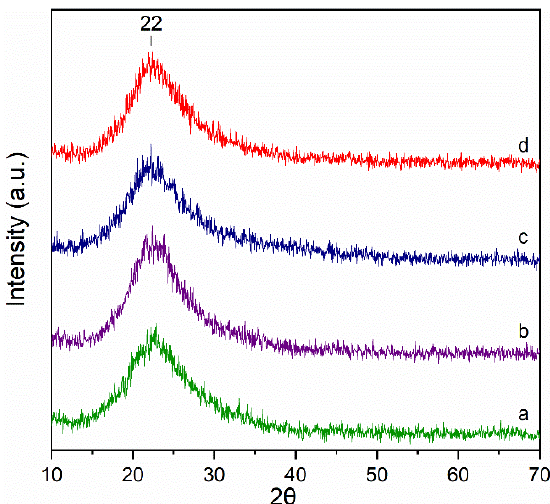
Figure 3. X-ray diffraction (XRD) patterns of samples: (a) SiO 2 , (b) NH 2 -SiO 2 , (c) Pd-P/NH 2 -SiO 2 , (d) Pd 0 /NH 2 -SiO 2 .